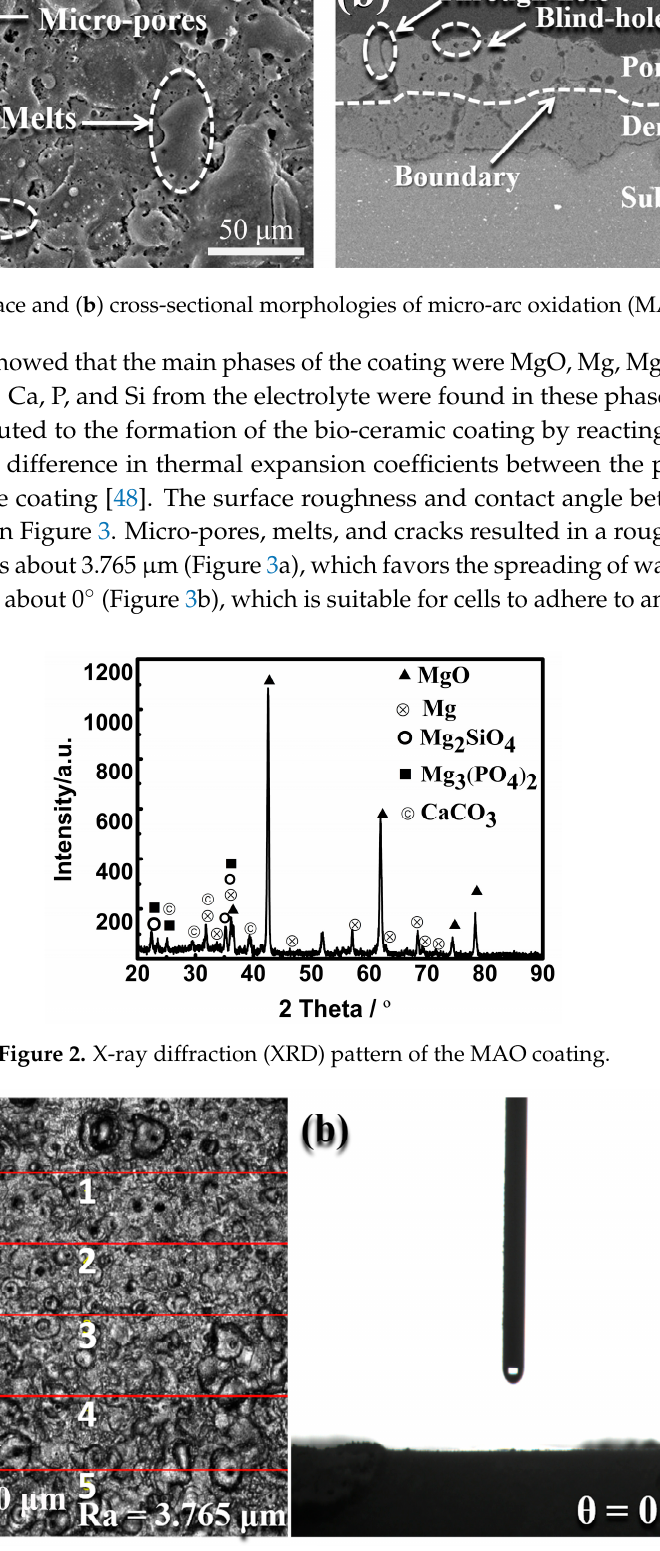
Figure 3. ( a ) Surface roughness of the MAO coating and ( b ) water contact angle of the MAO